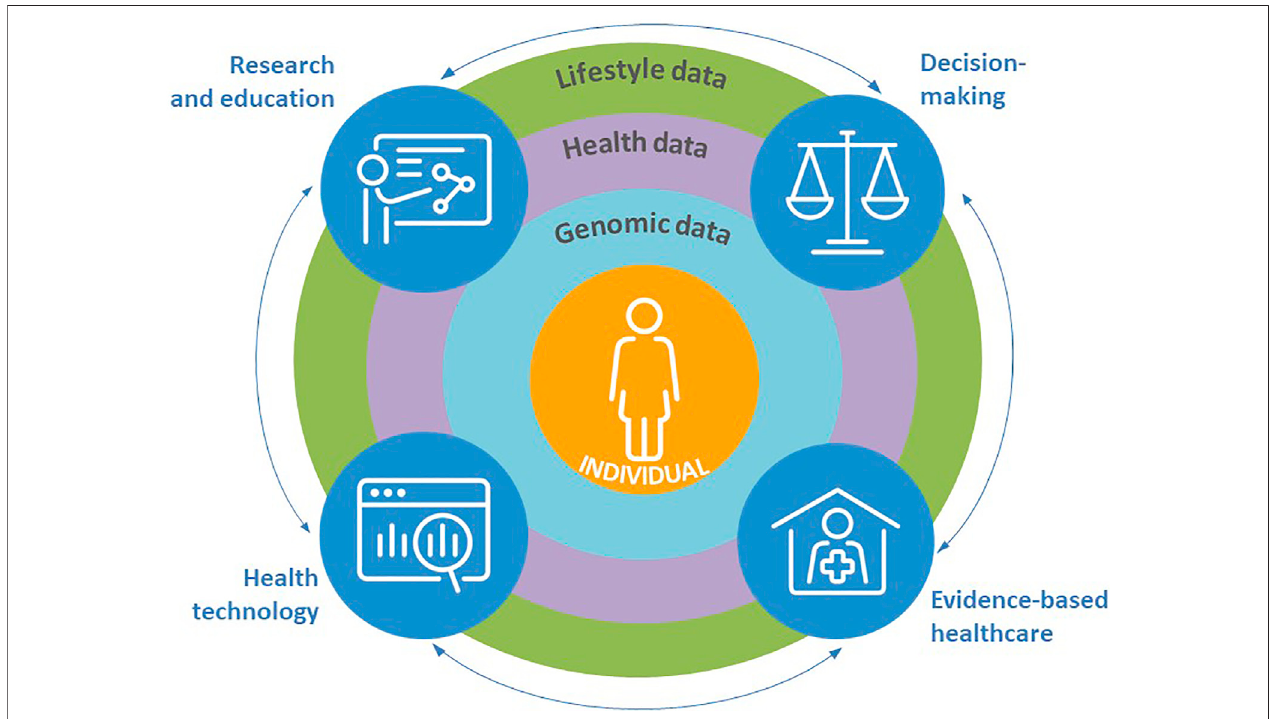
FIGURE 1 | A concept for data-driven precision healthcare in